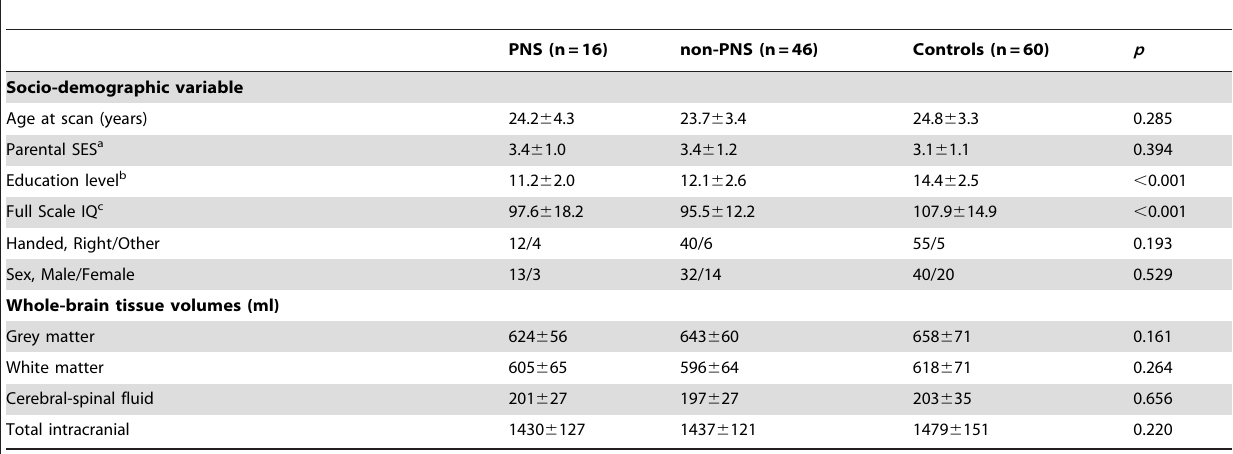
Table 1. Socio-demographic characteristics and whole-brain tissue volumes for PNS patients, non-PNS patients, and controls.